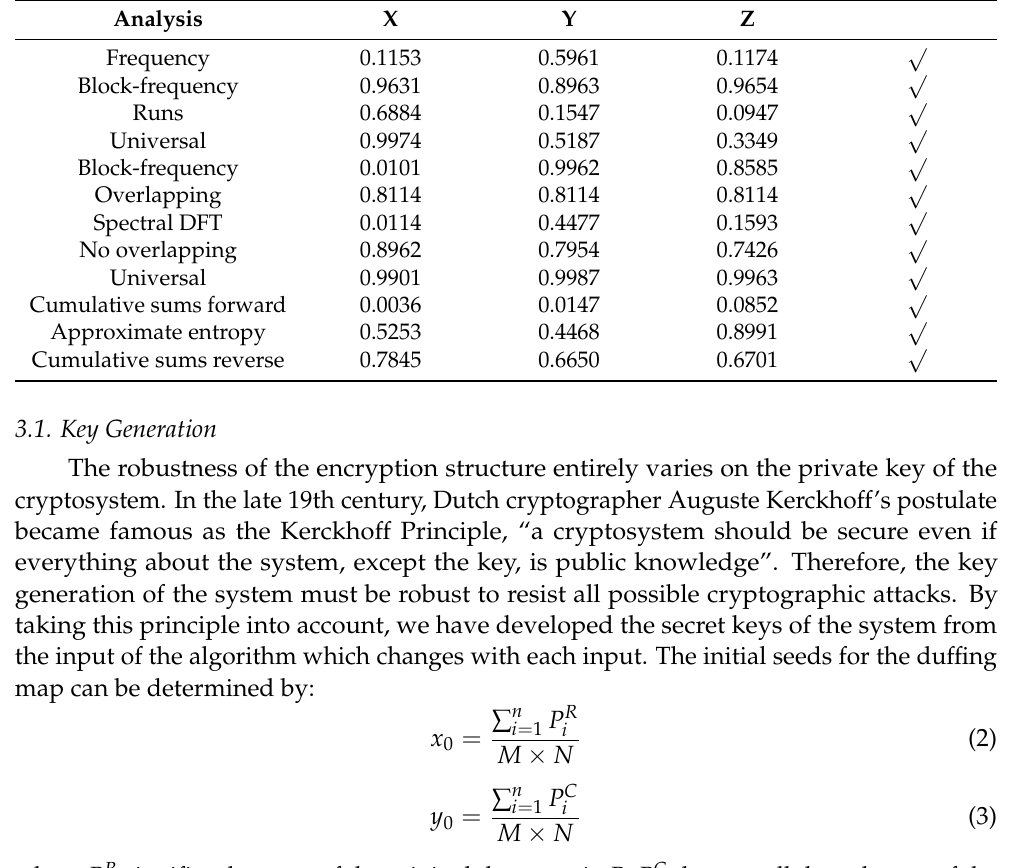
p Values for Each Chaotic